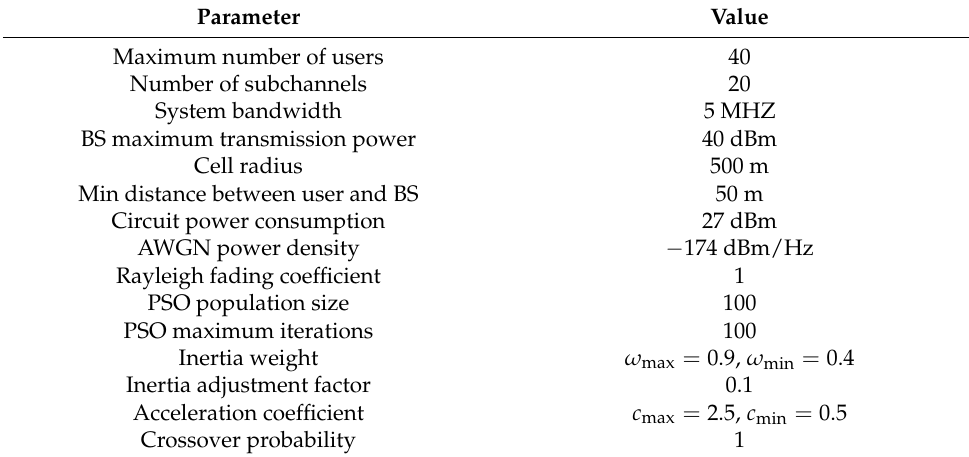
Table 1. Simulation parameters for downlink NOMA systems.